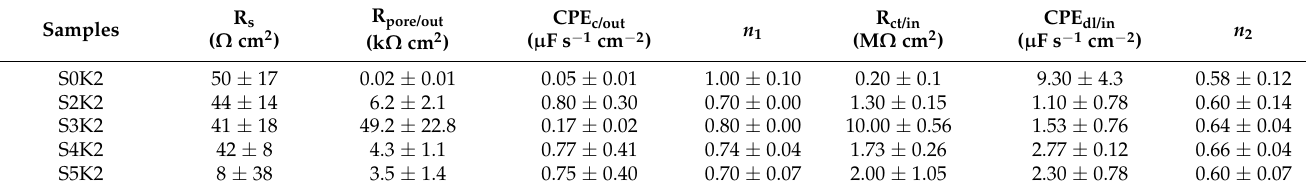
Table 3. Fitting results of EIS analysis for the PEO coatings prepared from the coating solutions containing different concentrations of SMS after 24 h immersion in 3.5 wt.% NaCl solution at pH